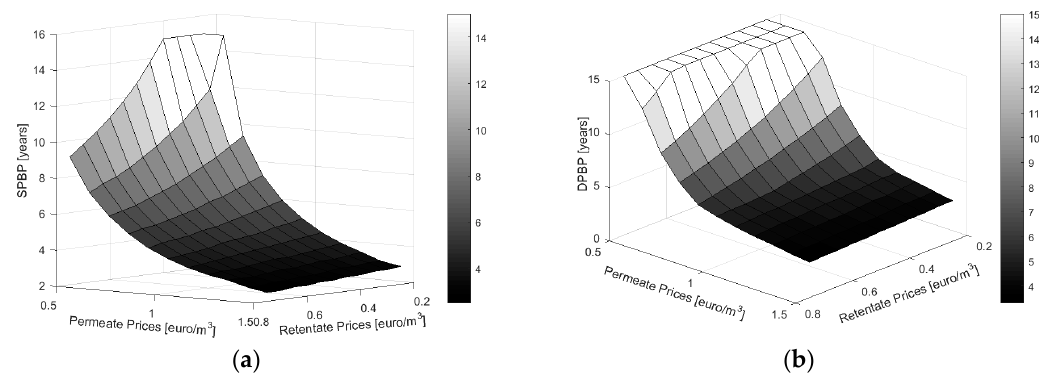
Figure 6. ( a ) SPBP results by varying the prices of the retentate and permeate streams; ( b ) DPBP results by varying the prices of the retentate and permeate